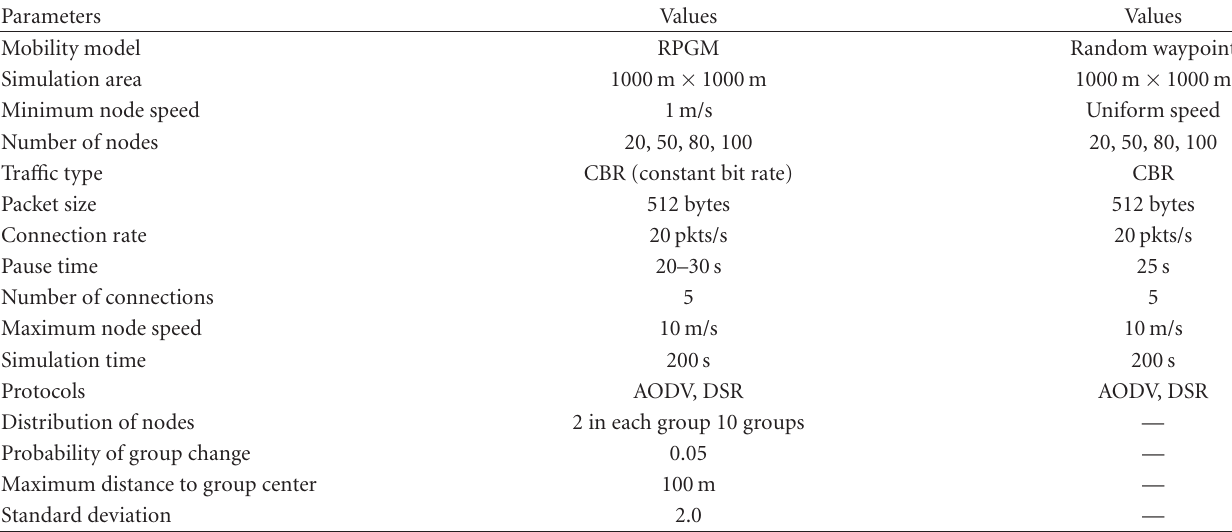
Table 2: Parameters for RPGM and random waypoint-node density